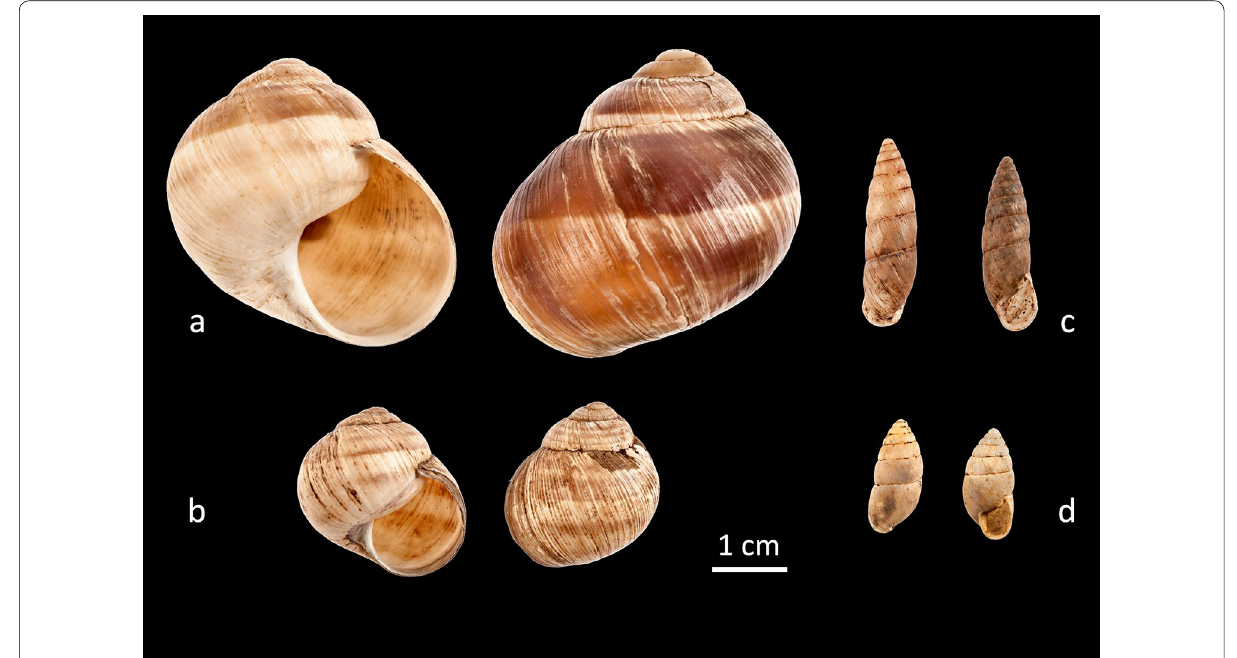
Fig. 2 Shells of a Helix asemnis ; b Helix nucula ; c Mastus rossmaessleri ; d Mastus